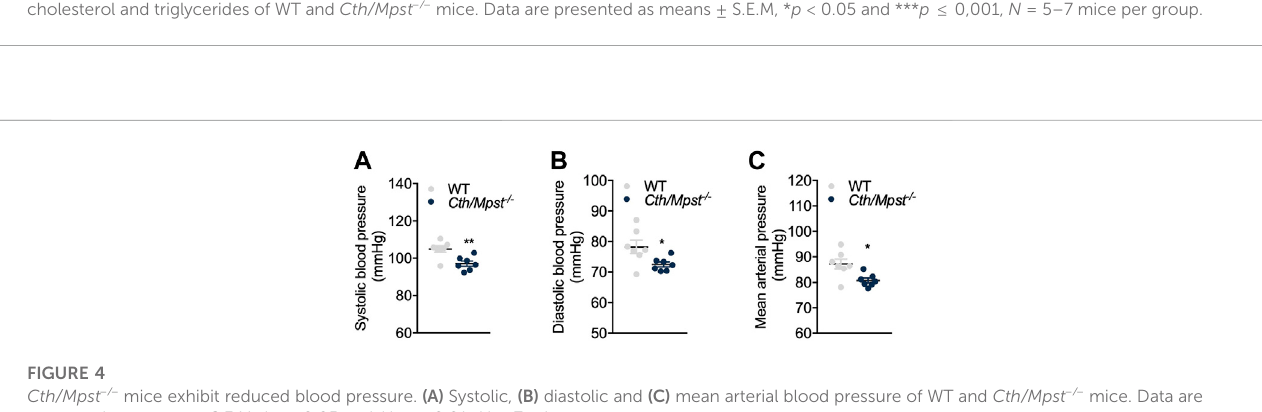
FIGURE 3 A lterations in serum-biochemical parameters after the Cth/Mpst double ablation. Serum levels of (A) alkaline phosphatase (ALP), alanine transaminase (ALT), aspartate aminotransferase (AST), (B) creatine kinase (CK), lactate dehydrogenase (LDH), α -amylase, (C) creatinine, urea, uric acid, albumin, (D) transferrin, ferritin, (E) total-bilirubin, direct-bilirubin, (F) glucose, cholesterol, high-density lipoprotein (HDL) cholesterol, low-density lipoprotein (LDL) cholesterol and triglycerides of WT and Cth/Mpst − / − mice. Data are presented as means ± S.E.M, * p < 0.05 and *** p ≤ 0,001, N = 5 – 7 mice per group.